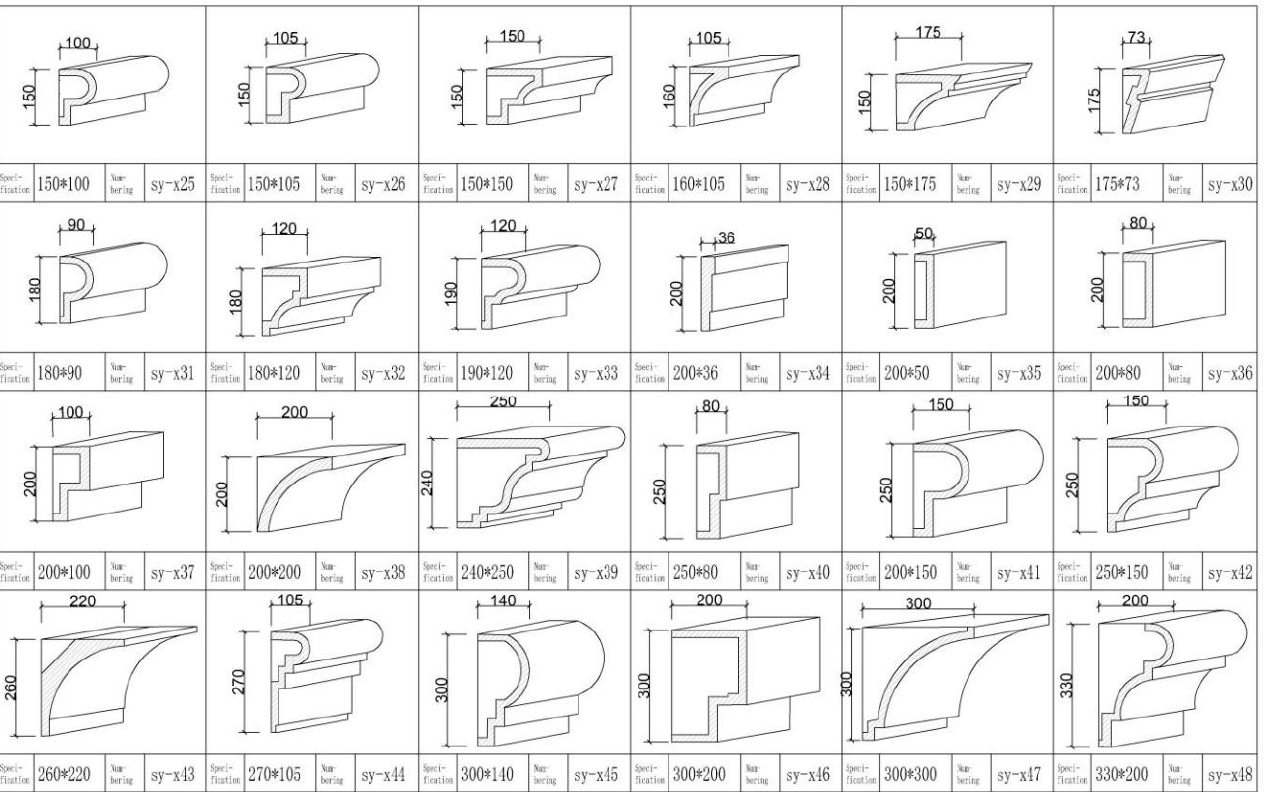
Figure 12. Line style series. (Source: the authors.).